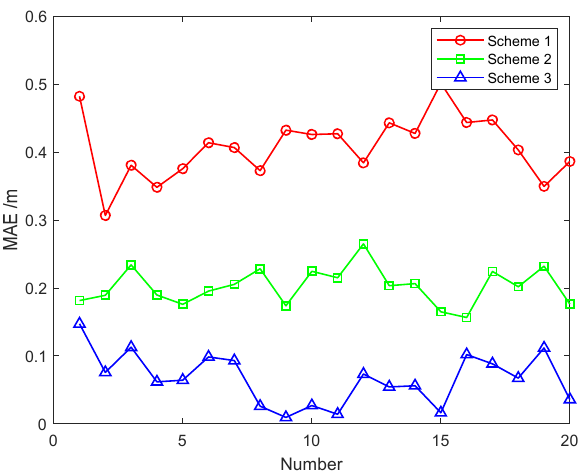
Figure 9. The MAEs of position errors (m) in the 20 experiment groups.